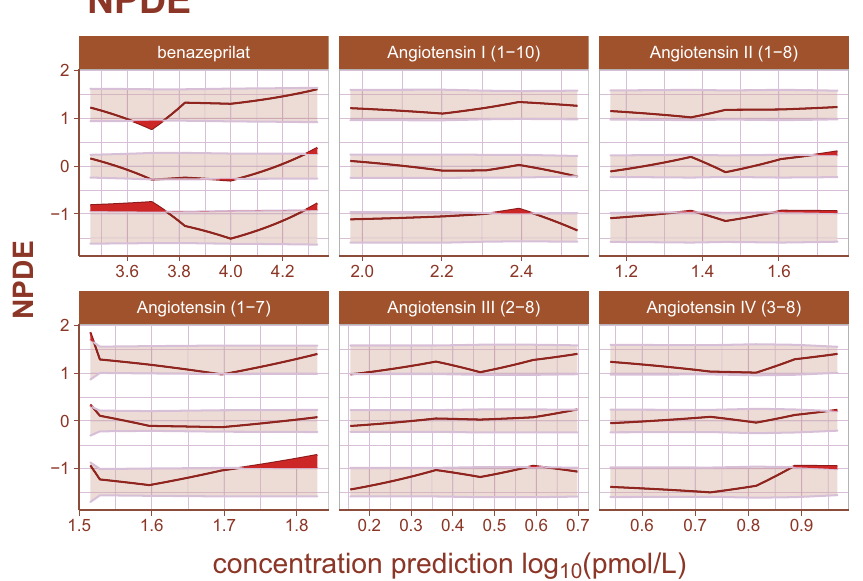
Figure 6. Normalized prediction distribution errors. Normalized prediction distribution errors (NPDEs) are an analog to residuals used for diagnosing both model structural misspecifications as well as the performance of the residual error model. The distribution of a well-specified model is normal, ideally. Bands represent the 90% prediction band for the 95th, 50th, and 5th percentiles, respectively. Curves are the observed percentiles for the 95th, 50th, and 5th percentiles, respectively. Data are binned at regular intervals to derive these average trends. For each binning range, if the structural model fits the data well, observed percentiles will be symmetrically distributed across a 50th percentile curve which falls within the 50th percentile band. If the error model is well specified, observed percentiles will fall within prediction bands. Any misspecification is ideally random. The model appears to underpredict angiotensin (1–7) for small measured values slightly, but otherwise there is high agreement between model and